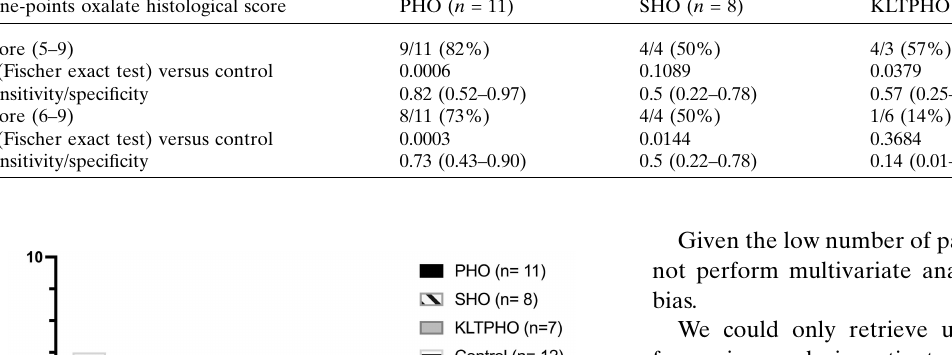
Table 1 Contingency nine-points score showing sensitivity and specificity of the score. Nine-points oxalate histological score